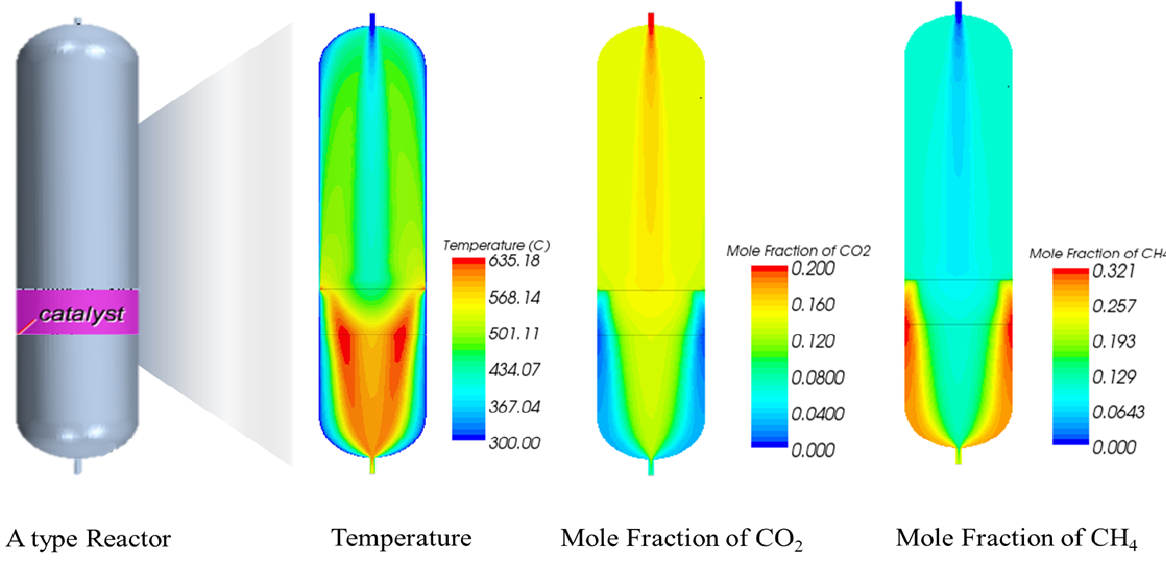
Figure 2. Reacting flow simulation for the A-type reactor. Table 1. Composition of temperature and exhaust gases according to reactor types.